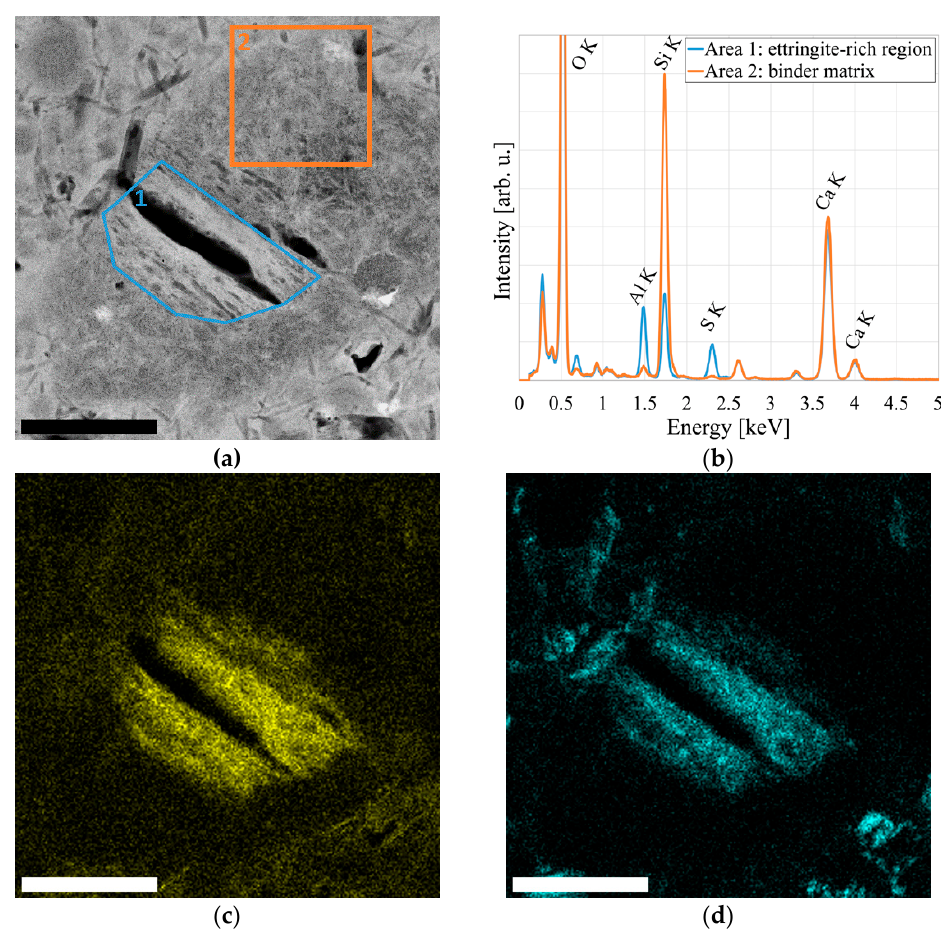
Figure 6. Sample region showing strong ettringite transformation around a nanoscale crack: ( a ) HAADF-STEM image indicating where spectra were extracted; ( b ) Corresponding EDS spectra; ( c ) EDS map of aluminum distribution; ( d ) EDS map of sulfur distribution. Scale bar is 500 nm.